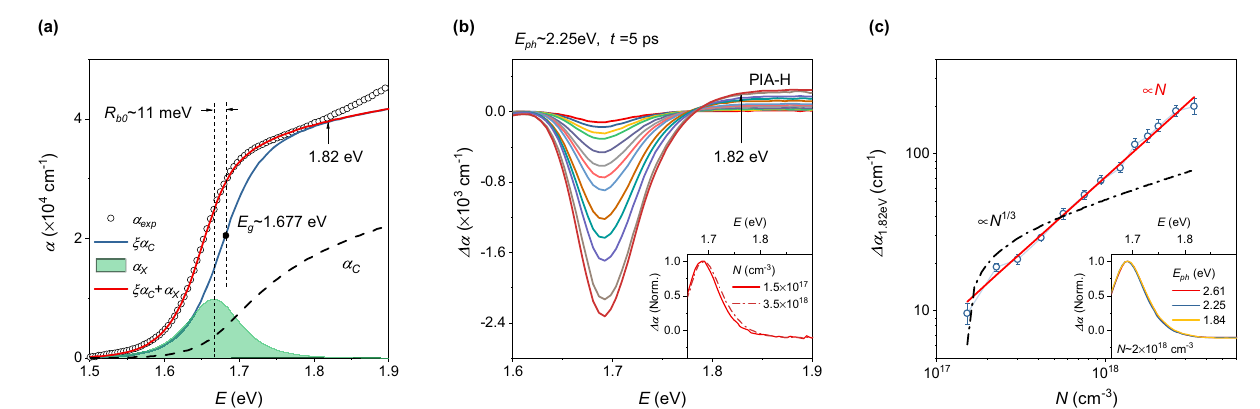
Fig. 1 Ground-state absorption and transient absorption spectra of CsFAMA thin fi lms. a Elliott model fi t to the ground-state absorption spectrum. The dashed line denotes the continuum absorption, in case excitons are fully screened ( ξ = 1). The divergence indicated at 1.82 eV implies that parabolic band dispersion is invalid for E > 1.82 eV. b TA spectra recorded at 5 ps delay time for carrier densities varying from 1.5 × 10 17 to 3.5 × 10 18 cm − 3 . The pump wavelength was 550 nm (photon energy ~2.25 eV). PIA-H represents the photo-induced absorption at the high-energy part of the TA spectra. Inset: normalized TA spectra for carrier densities of 1.5 × 10 17 and 3.5 × 10 18 cm − 3 , respectively. c Plot of the amplitude of the PIA-H signal at E = 1.82 eV versus the carrier density. The error bars indicate standard errors. The red solid line is a linear fi t to the data. The dash-dotted line is a power law fi t with ∝ N 1/3 . Inset: normalized TA spectra for a carrier density of ~2 × 10 18 cm − 3 , generated by different pump photon